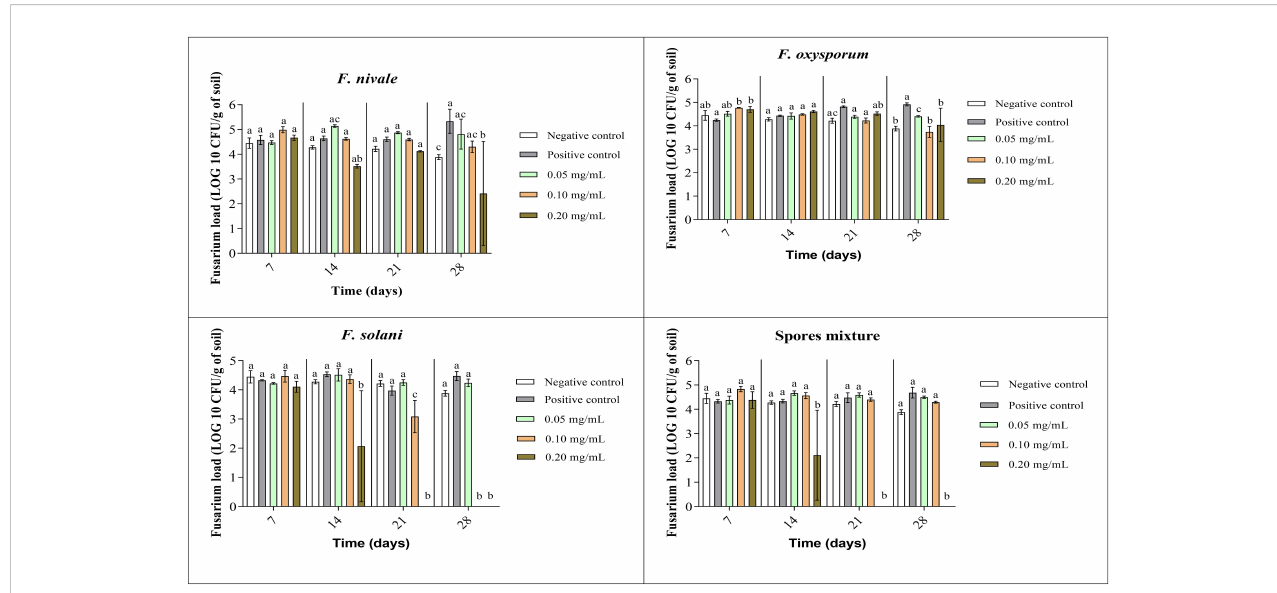
FIGURE 7 Fusarium load during treatment of ryegrass pots with carvacrol for four weeks in normal soil under greenhouse. Means (± SD, n = 3) denoted by the same letter indicate no signi fi cant difference according to Tukey ’ s multiple range tests at p<